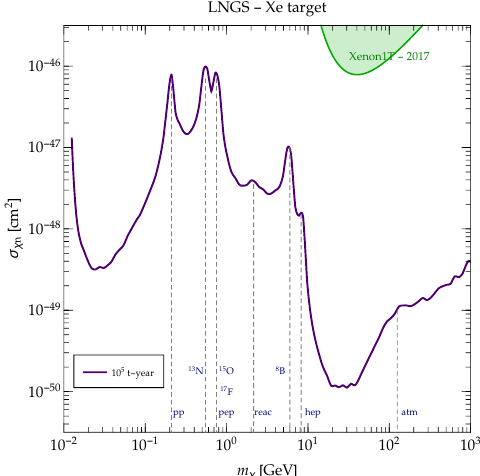
Figure 5.1: Standard Model Neutrino discovery limit of an “academic” experiment = 0.01 eV energy with 10 5 ton-years exposure and E th